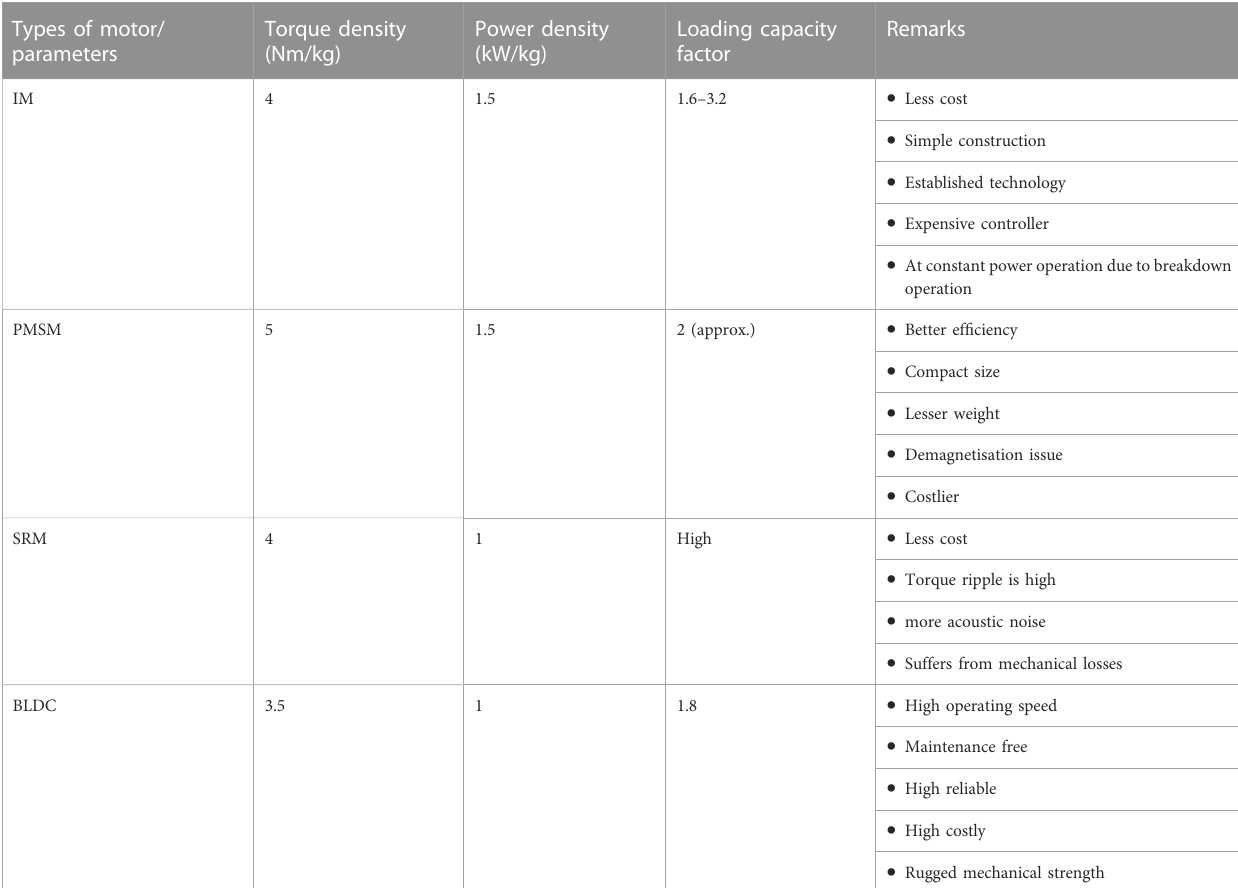
TABLE 1 Performance comparison of different motors. Types of motor/